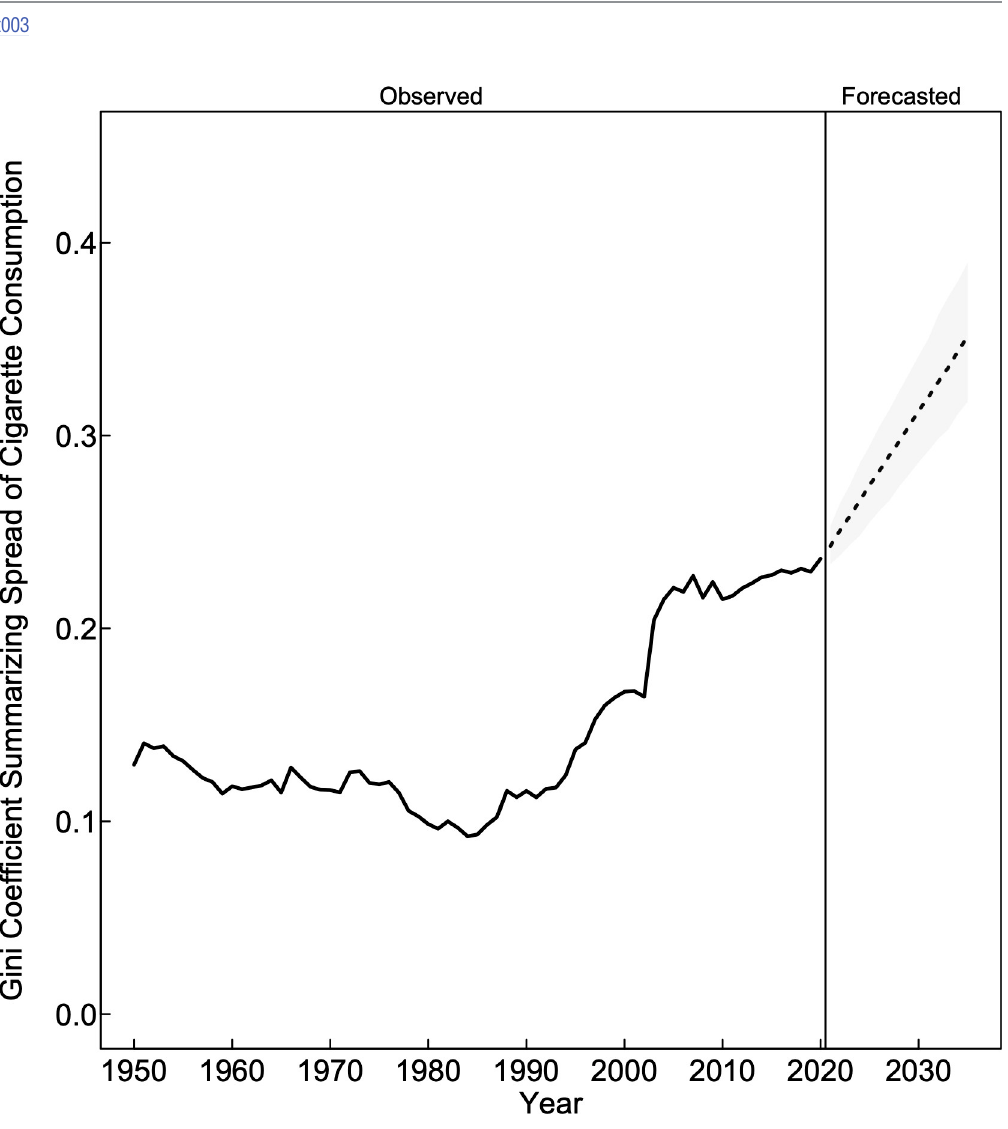
Fig 3. Inequity in cigarette consumption across US states. Overall declines in cigarette consumption from the mid-1980s onward were accompanied by growing inequality across US states, as measured by the Gini Coefficient. Inequality is expected to continue to grow if recent trends are maintained. Note: the forecasts are based on autoregressive integrated moving average models selected by Hyndman and Khandakar’s model selection algorithm and historical trends for each state with data for each forecast based on estimates from 1996 to 2020; Gini Coefficients are calculated within each year, across observed or forecast cigarette consumption for all available US